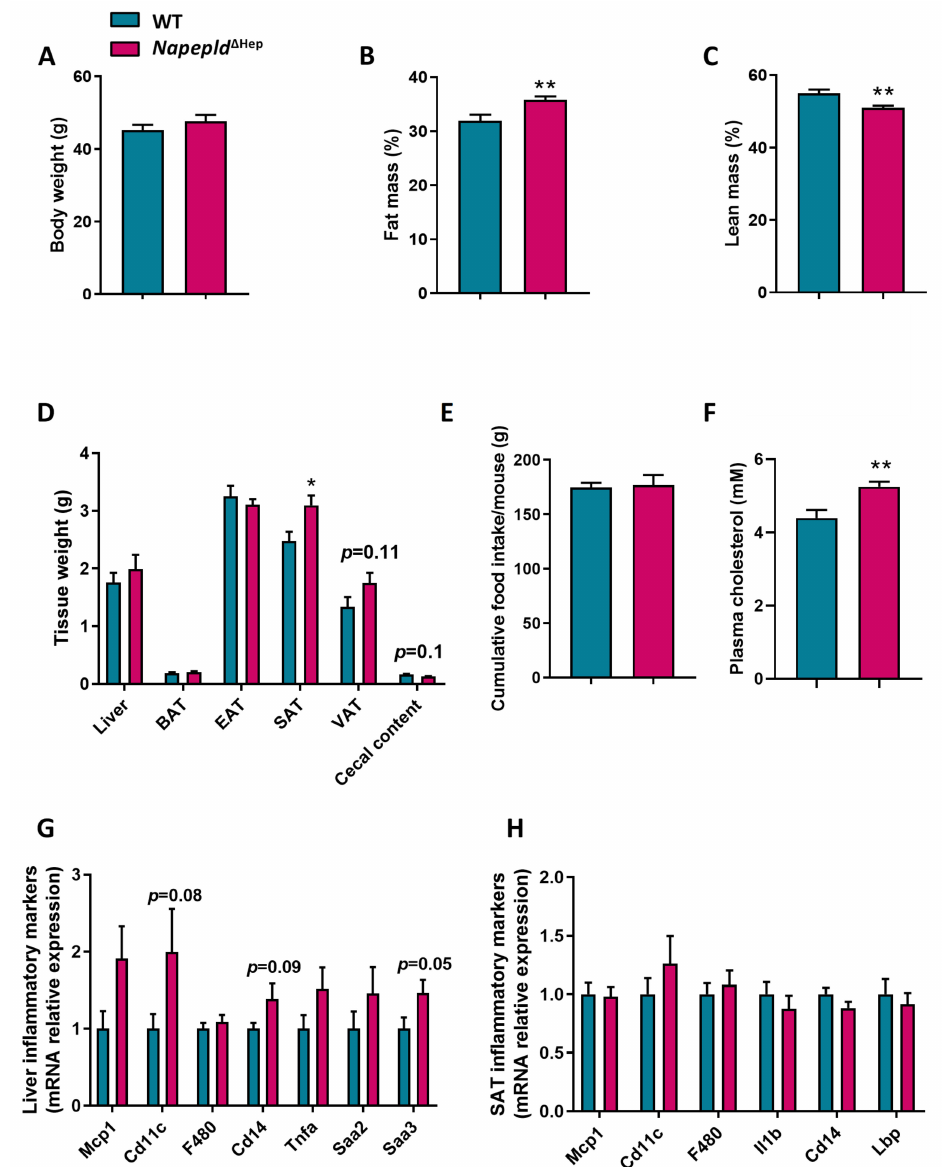
Figure 5. Deletion of Napepld partially accentuates the obese phenotype induced by a high-fat diet. ( A ) Body weight (g) after an 8 weeks period. ( B ) Fat mass (%) over an 8 weeks period. ( C ) Lean mass (%) after an 8 weeks period. ( D ) Weight (g) of di ff erent tissues: liver, brown adipose tissue (BAT), epididymal adipose tissue (EAT), subcutaneous adipose tissue (SAT), visceral adipose tissue (VAT) and cecal content. ( E ) Cumulative food intake per mouse (g) after an 8 weeks period. ( F ) Plasma cholesterol concentration (mM). ( G ) Liver and ( H ) SAT inflammatory markers measured by real-time qPCR. Dark blue: WT HFD mice. Dark pink: Napepld ∆ Hep HFD mice ( n = 11). Data are presented as the mean ± s.e.m. * and ** indicate a significant di ff erence versus WT HFD (Respectively p < 0.05 and p < 0.01) according to the t -test (except for (B) that is according to a two-way ANOVA followed by a Tukey post hoc